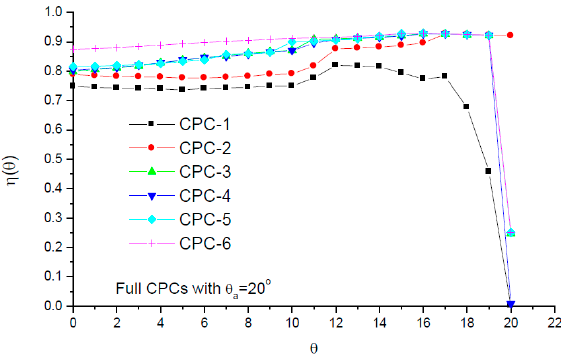
Figure 8. Angular variations of optical efficiency of full CPCs with θ a = 20°.